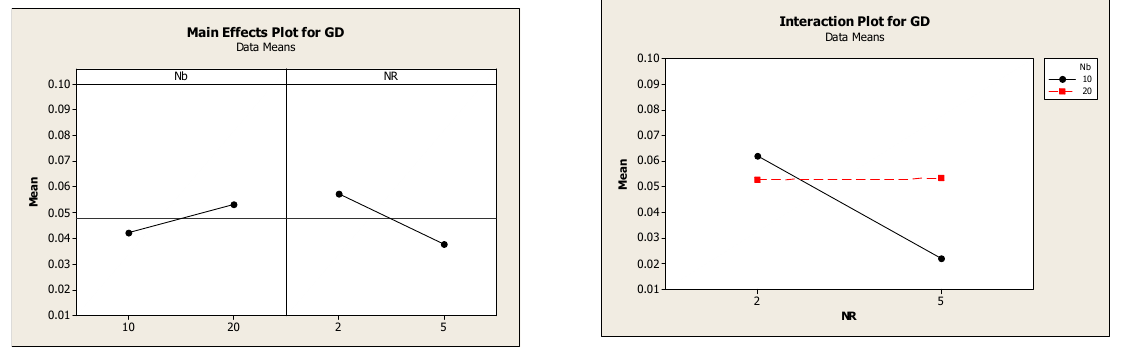
Interaction Plot for IGD Data